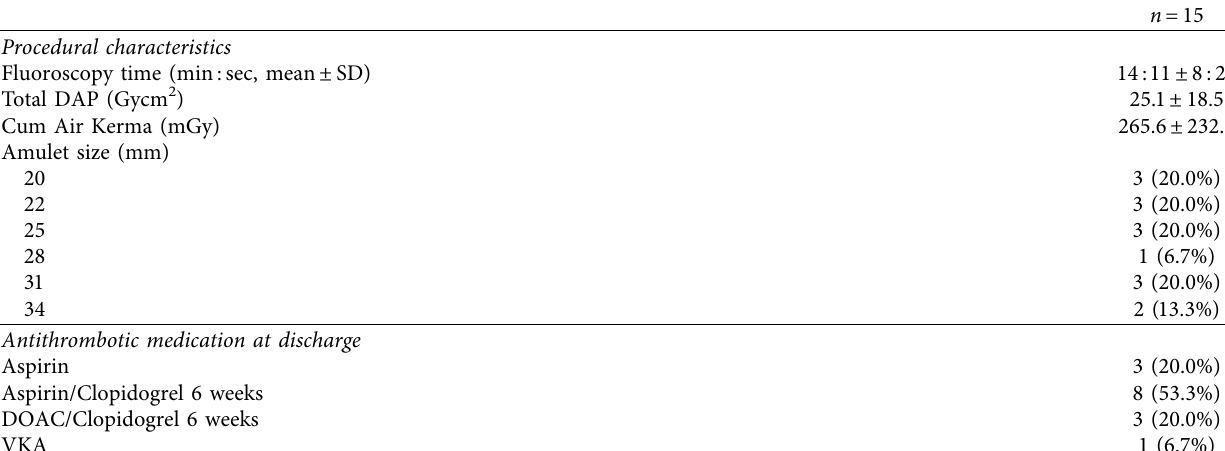
Table 3: Procedural characteristics and antithrombotic